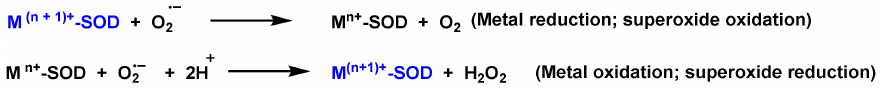
Figure 4. SOD-catalyzed dismutation of the superoxide radical. M = [Cu ( n = 1); Mn and Fe ( n = 2)]. The oxidation state of the metal cation varies between n and n +